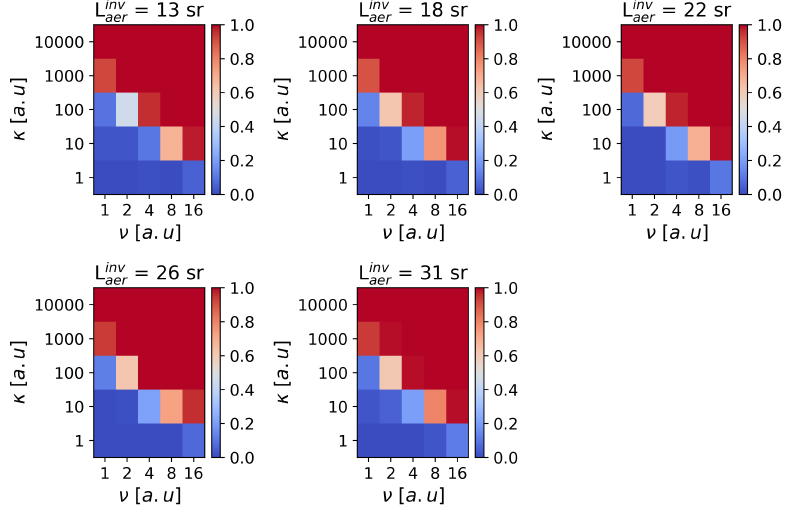
Figure 7. Maps of detection for the 25 combinations of κ and ν values, where the colors represent the detection frequency (ranging from 0 to 1). Each panel shows the biased inversion, with L inv aer varying from 13 to 31